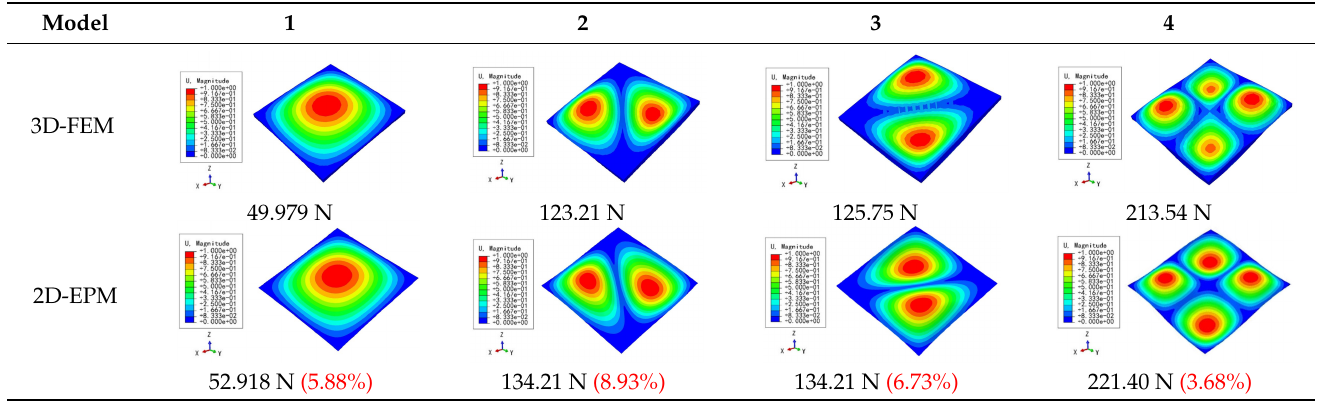
Table 10. Comparison of the buckling modes and buckling loads of the orthogrid HSP under SSSS boundary conditions predicted by different models.